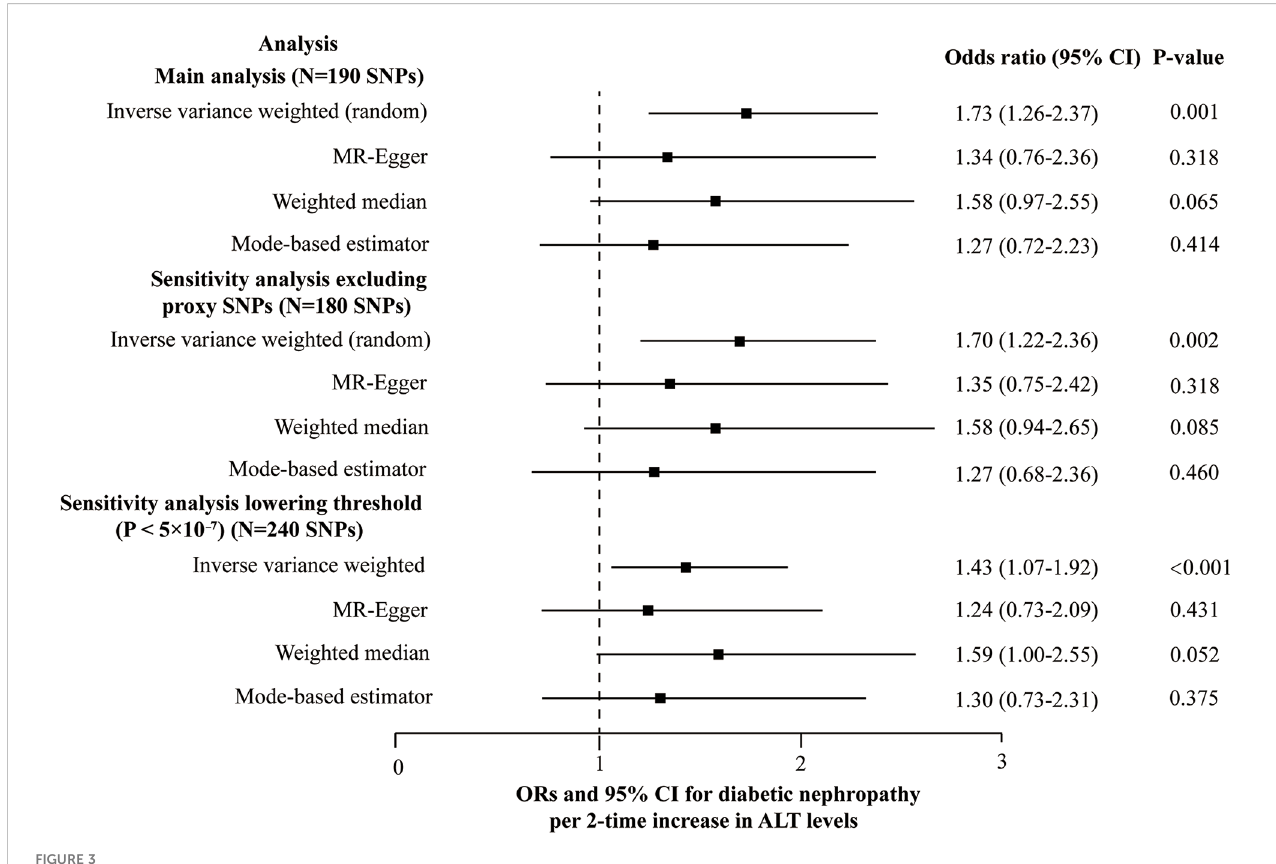
FIGURE 3 Forest plot of the MR main and sensitivity analyses of ALT and diabetic